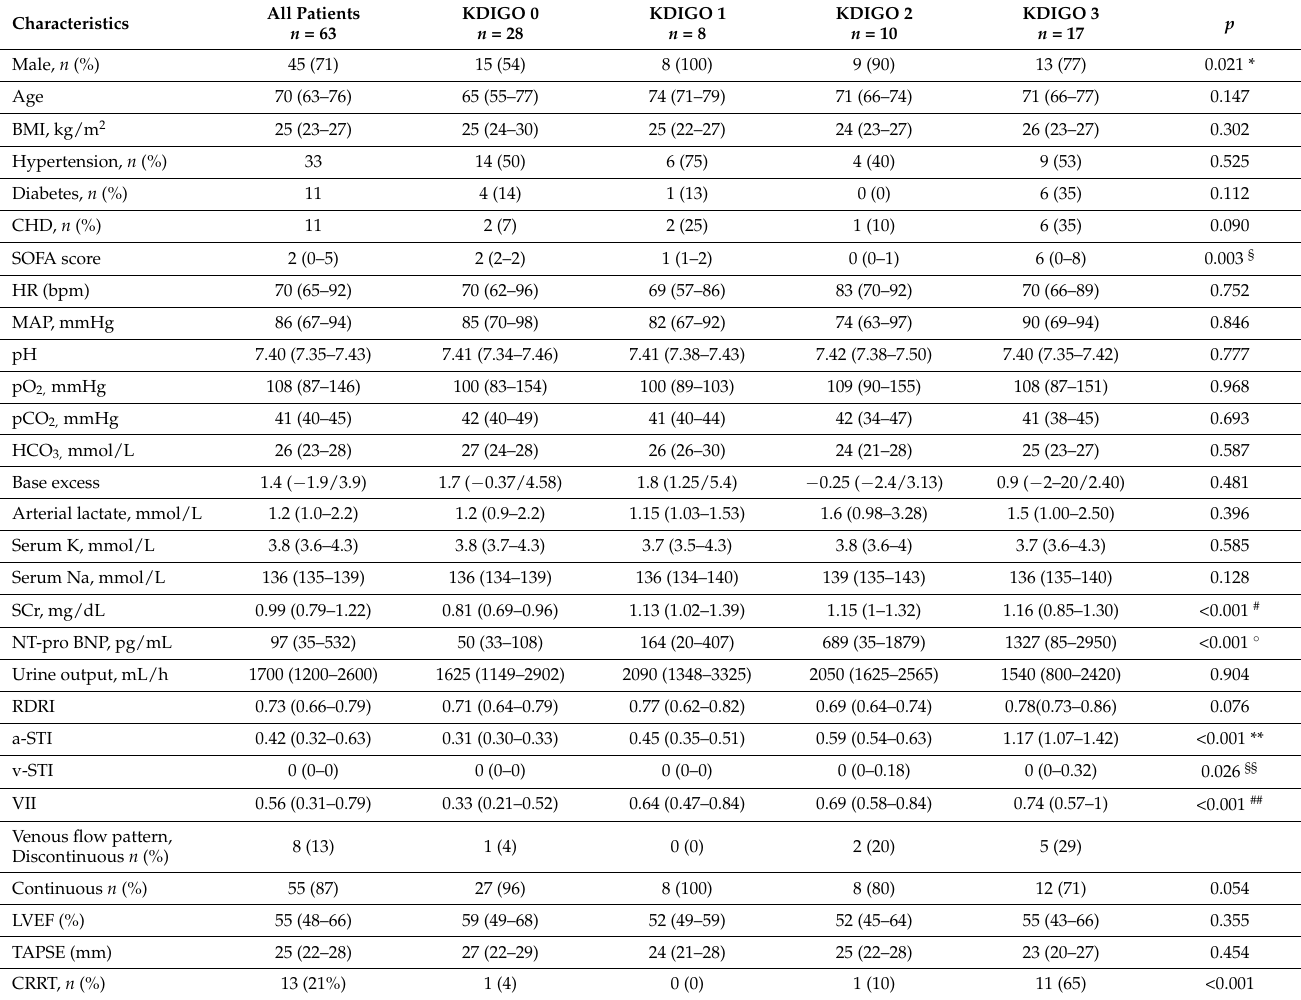
Table 1. Clinical characteristics, laboratory data and intrarenal Doppler parameters at ICU admission according to KDIGO stage at day